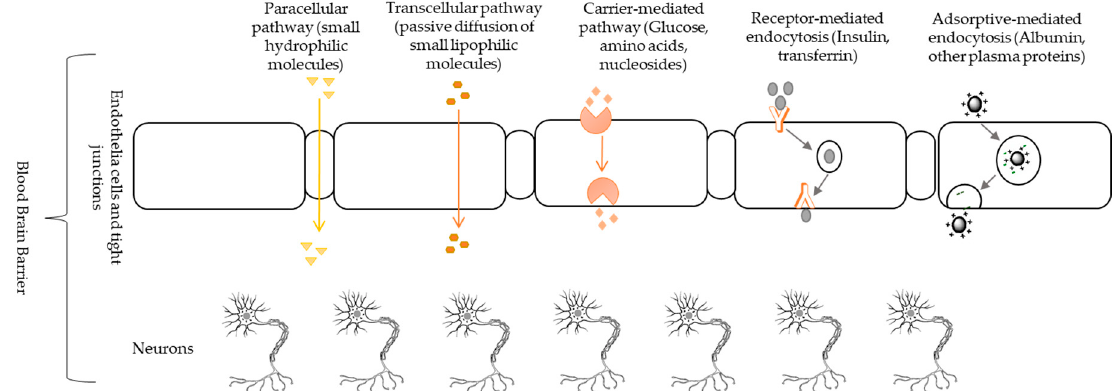
Figure 4. Main pathways for nanoparticles to cross the blood-brain barrier. Penetration of charged molecules (including cationic nanoparticles: liposomes and gold nanoparticles) depends on adsorptive-mediated endocytosis while molecules with high hydrophilicity (like transferrin conjugated nanoparticles, liposomes, poly(lactic-co-glycolic acid/poly (lactic acid)) needs receptor-mediated endocytosis. Carrier-mediated pathway is a substrate-specific process while small hydrophilic molecules penetrate through paracellular pathway. Passive diffusion of small lipophilic molecules, e.g., gold nanoparticles occur through transcellular pathway.